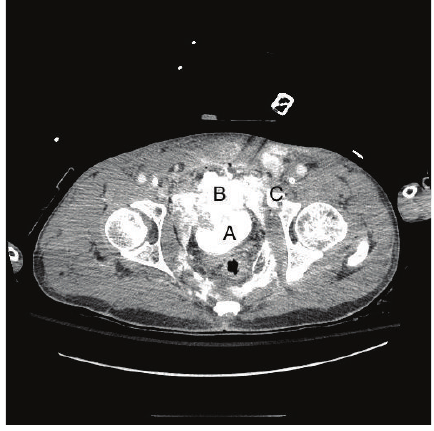
Figure 4: CT A/P demonstrating significant injuries in the pelvis including bladder injury with contrast extravasation and open book pelvic fractures. A: bladder filled with contrast. B: contrast extravasation anteriorly. C: fracture of the pubic ramus. Figure 5: Key: A: necrotic tissue. B: bladder mucosa. C: Foley